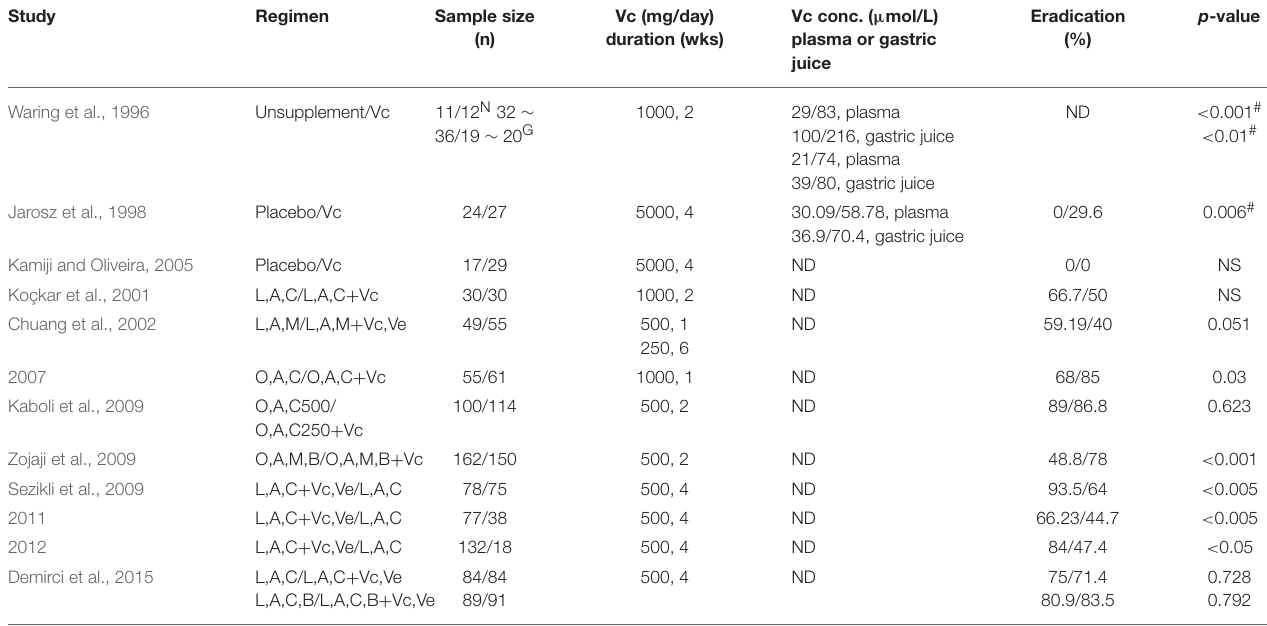
p -value Eradication (%)